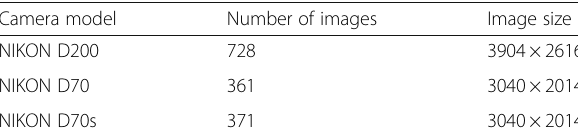
Table 4 Camera models and image information in the experiments Camera model